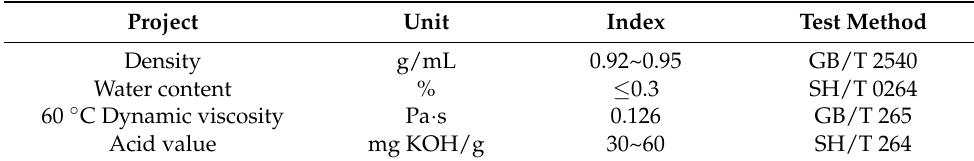
Table 2. Basic properties of bio-oil.